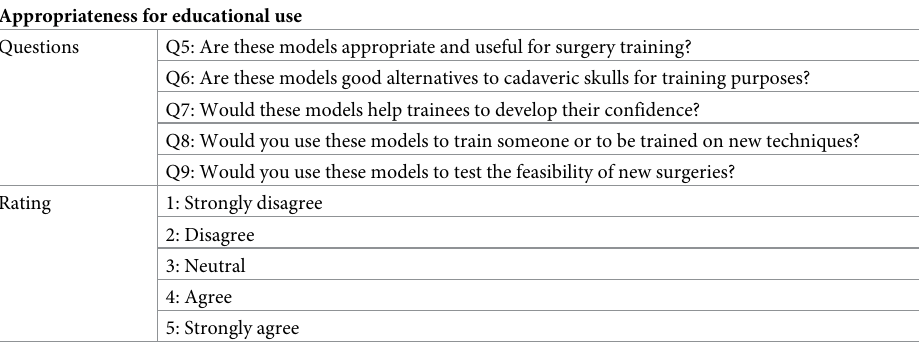
Table 2. Outline of survey questions: Appropriateness for educational use.